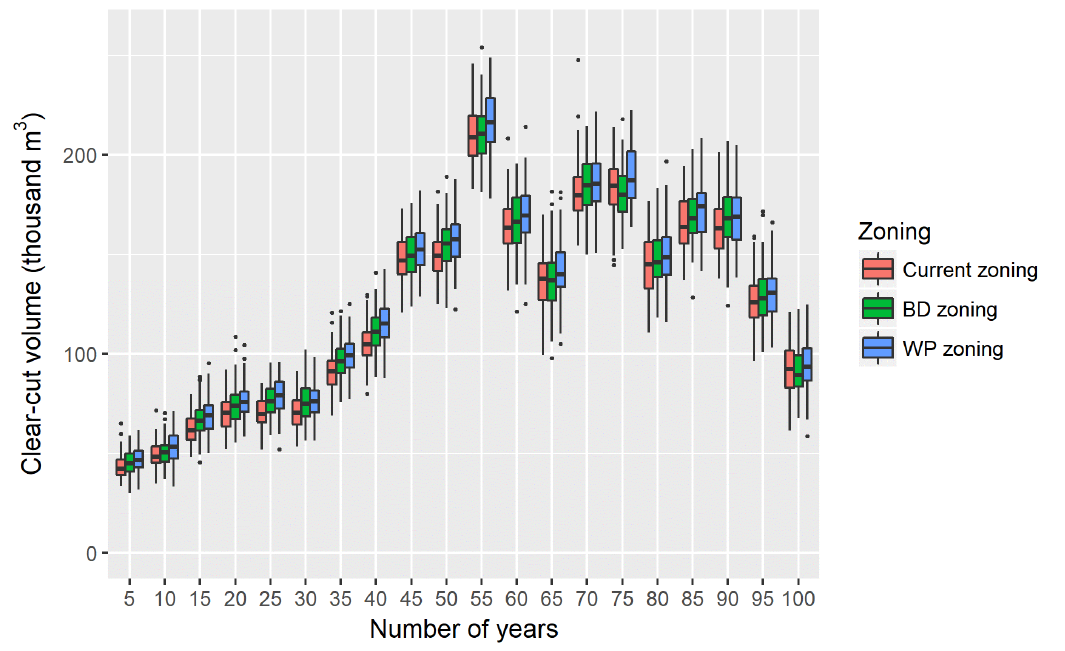
Figure 7. Change of wood production over 100 years simulated with the DSS. Boxes show median values, maximum and minimum values, and quartiles of each